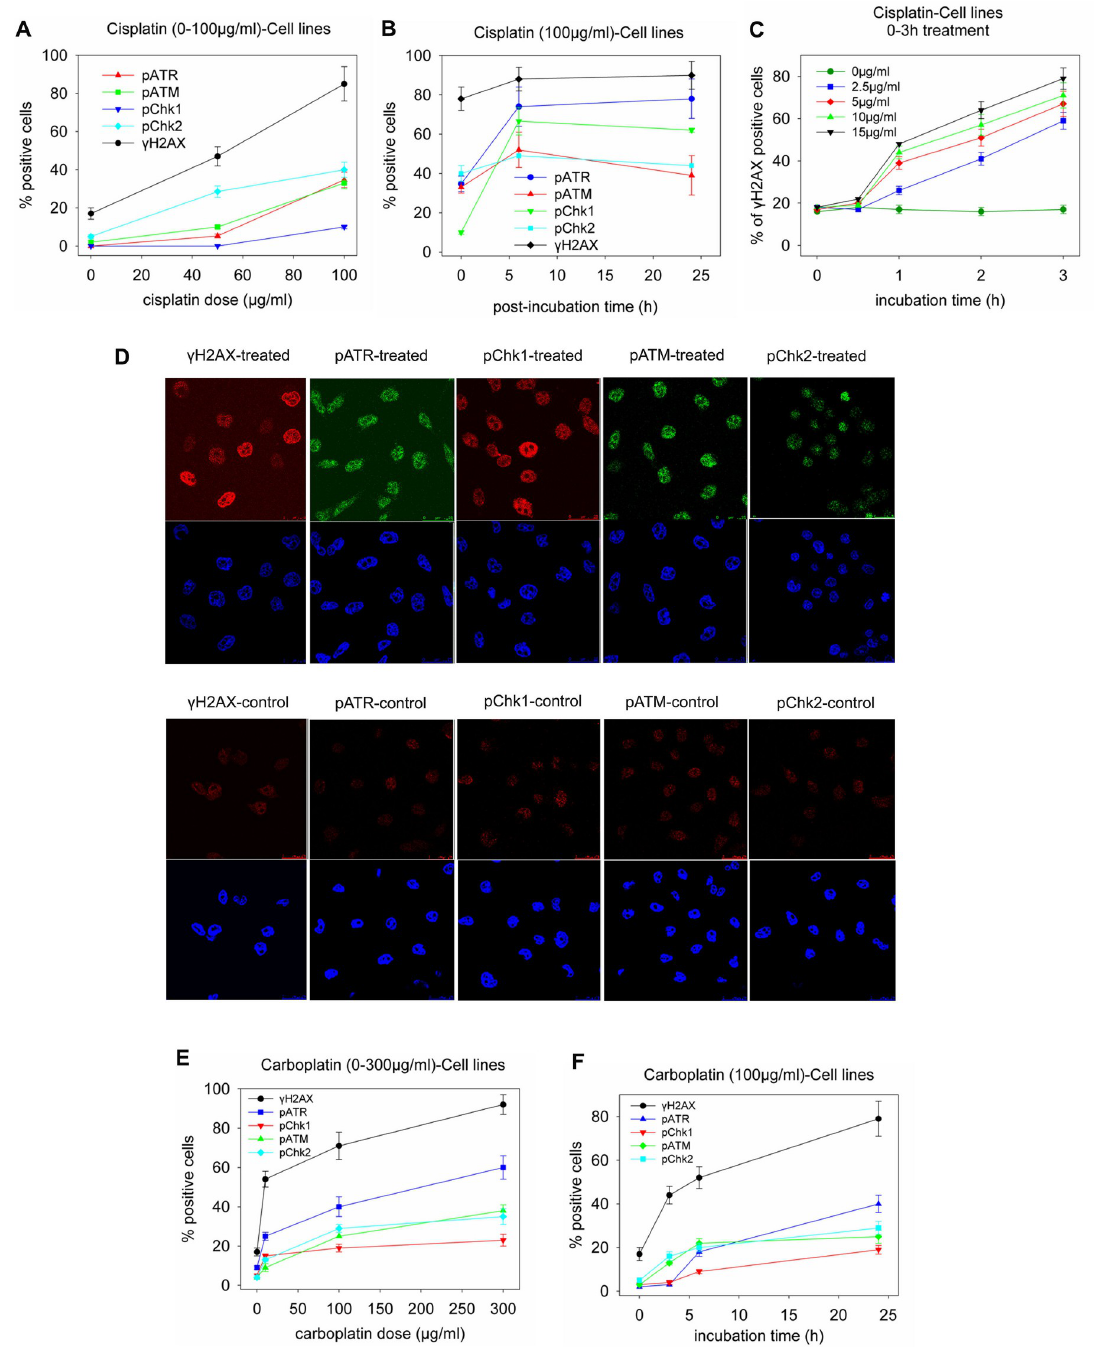
Fig 1. Changes in key molecules of the DDR pathways in ovarian carcinoma cell lines. A2780/C30 cells (representative of the two OC cell lines) were treated (A) with cisplatin (0–100 μ g/ml) for 3h, or (B) with 100 μ g/ml cisplatin, subsequently incubated in drug-free medium for various time-periods (0–24h), or (C) with relatively small doses (0–15 μ g/ml) of cisplatin for up to 3h, and analyzed at the end of the treatment using confocal microscopy. Positive cells: cells with more than 5 foci per cell. The error bars represent standard deviation. In (D) typical images showing the key molecules under study using microscope analysis of A2780/C30 cells treated with 100 μ g/ml of cisplatin for 3h; upper images, immunofluorescence antigen staining; bottom images, cell nuclei labeled with DAPI. Typical images showing the same key molecules in the control/untreated A2780/C30 cells are also presented. (E) A2780/C30 cells were treated with carboplatin (0–300 μ g/ml) for 24h or (F) with 100 μ g/ml carboplatin for various time-periods (0–24h) and analyzed using confocal microscopy. The error bars represent standard deviation. All assays were performed in